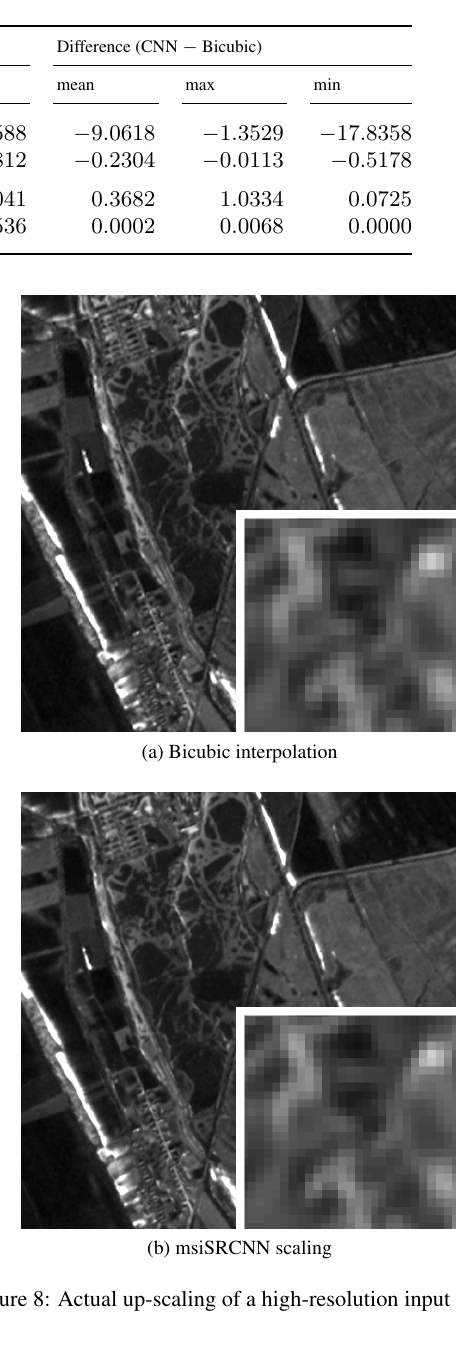
Table 1: Scaling results for our test dataset